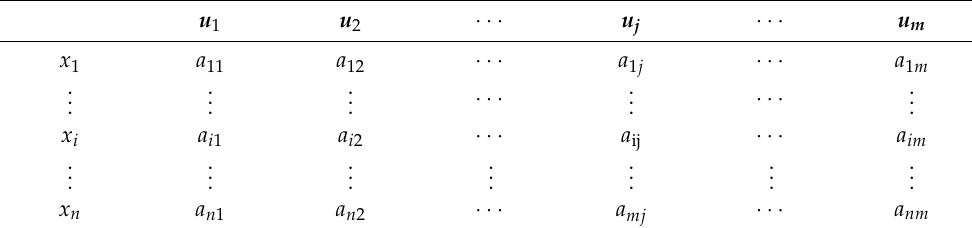
Table 6. Initial data